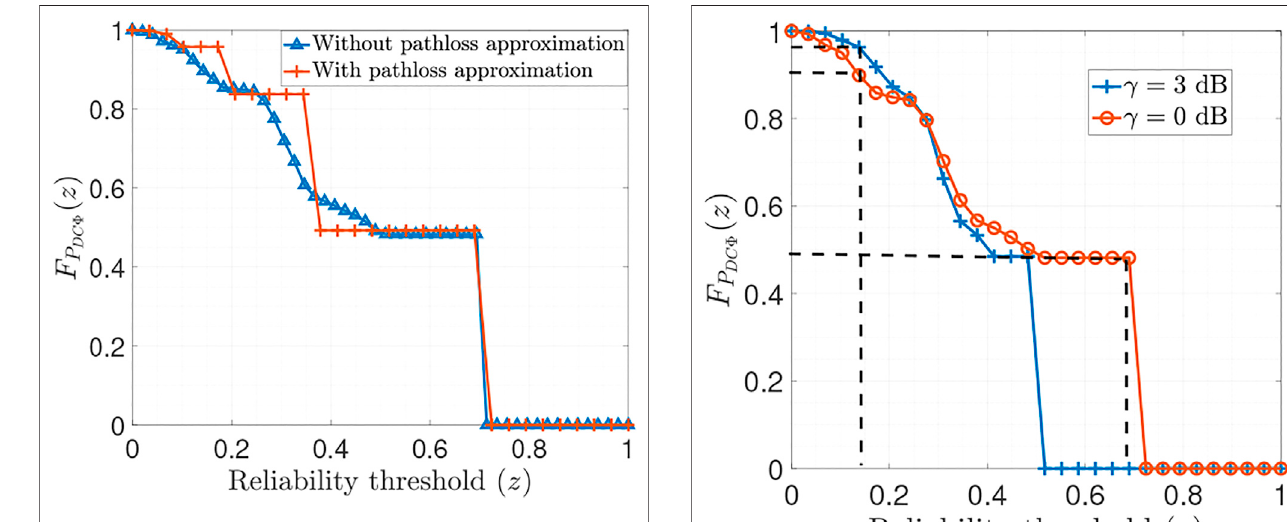
FIGURE 9 | Comparison of the meta-distribution of the SCNR with and without the path loss approximation of the clutter points. Here ϵ =0.5.